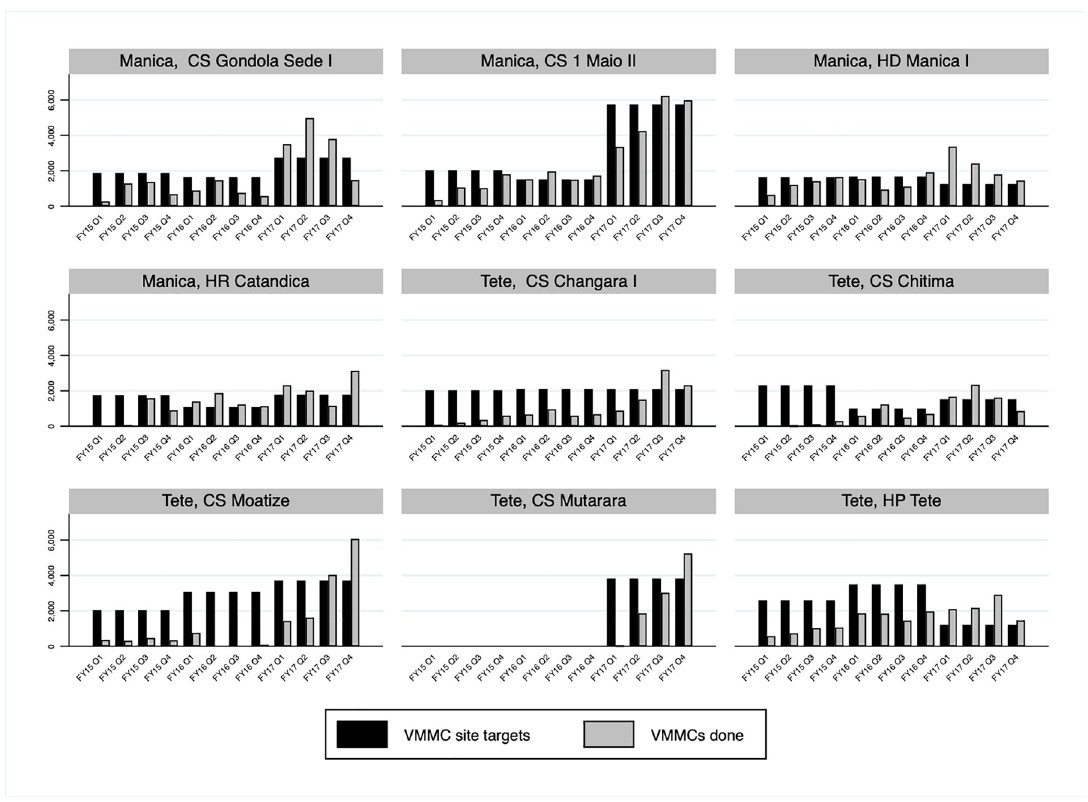
Fig 4. Voluntary medical male circumcisions (VMMCs) site targets and VMMCs performed in Manica and Tete, Mozambique FY15 Q1- FY17 Q4 by fixed service delivery site.